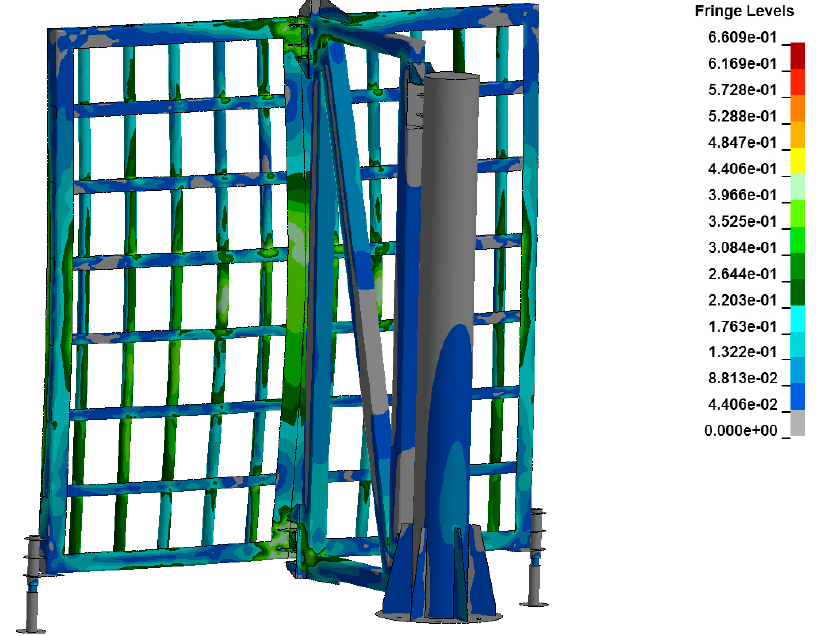
Figure 9. Reduced stresses according to Huber–Mises hypothesis (GPa) for maximum deformation—impact on the center of the shield.